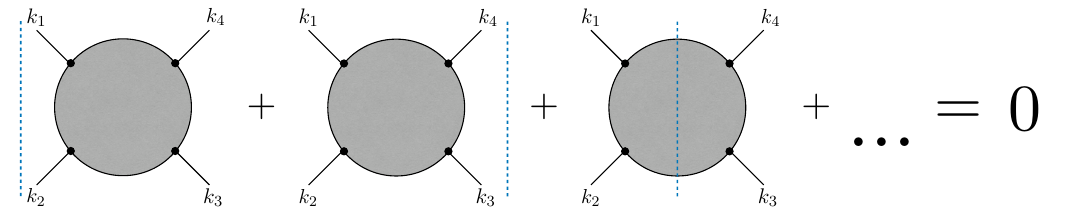
Figure 3 . Optical theorem for a QFT four-point function. The grey disk represents a general correlation function and not a Feynman diagram. The external lines label the momentum of the external operator. Operators to the (right) left of the blue line are (anti-)time-ordered in the four-point functions given in